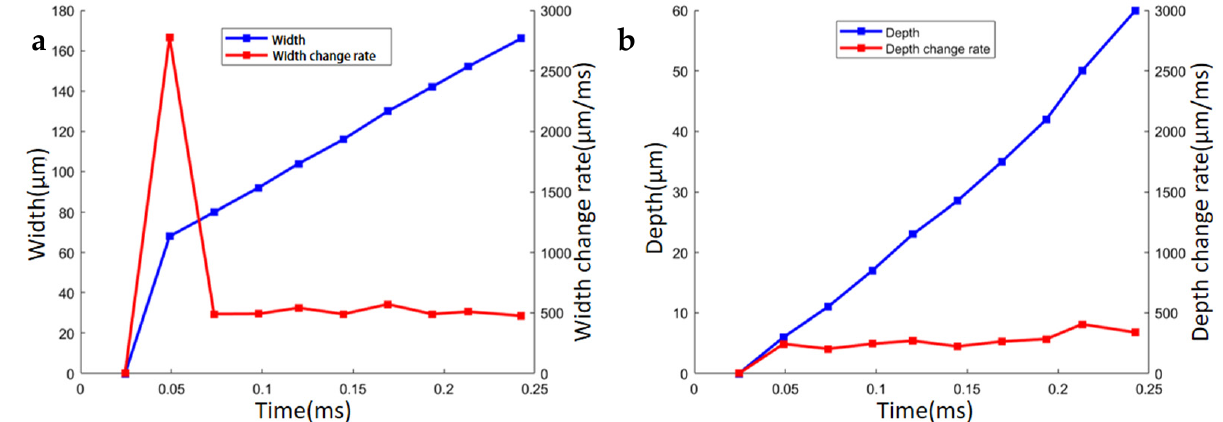
Figure 3. Micro hole variations with processing time: ( a ) width; ( b ) depth.